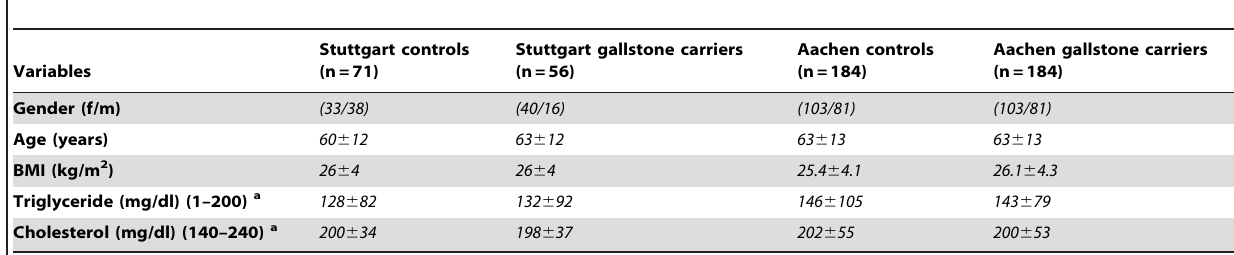
Table 3. Clinical characteristics of study participants from Stuttgart and Aachen cohorts.